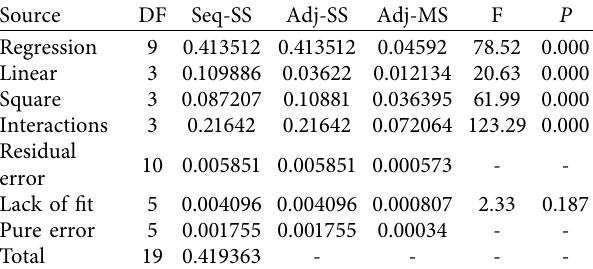
Table 9: Variance analysis for surface roughness, Ra.